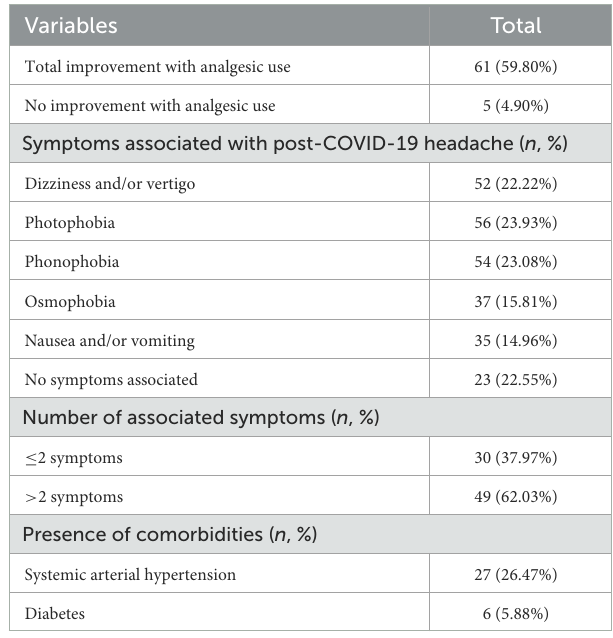
TABLE 1 Characteristics of the patients with headache and long COVID-19 in this